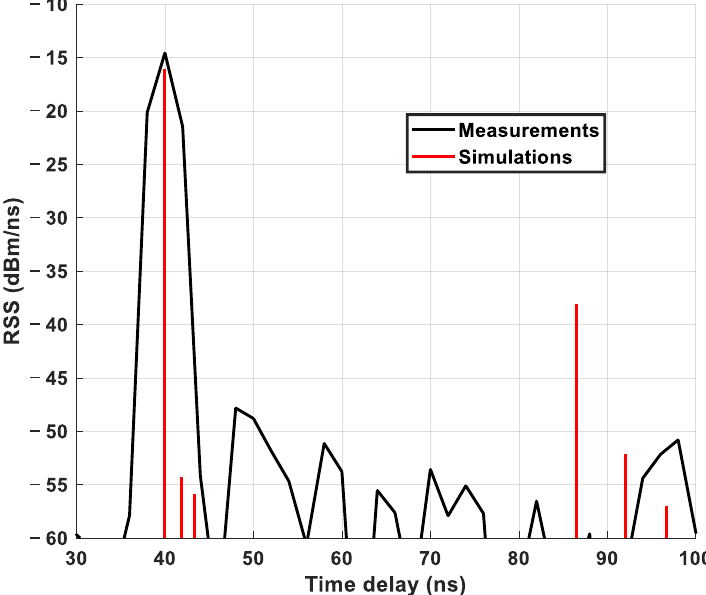
Figure 7. Comparison between simulations and measurements at LOS scenario.